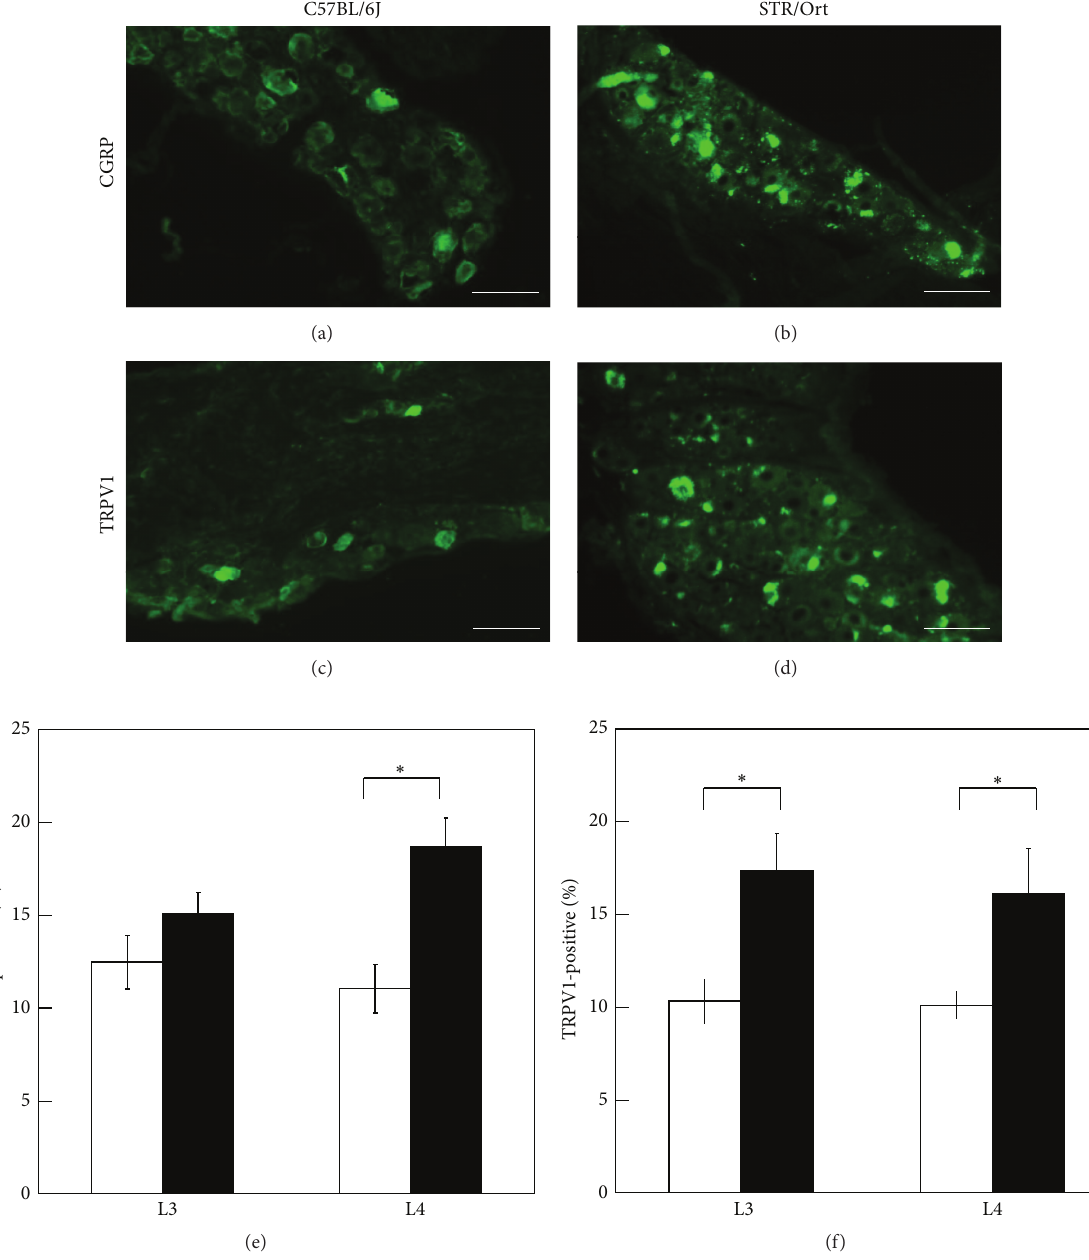
Figure 5: Expression of CGRP and TRPV1 in dorsal root ganglia. Expression of CGRP in L4 dorsal root ganglia of C57BL/6J (a) and STR/Ort mice (b). Expression of TRPV1 in L4 dorsal root ganglia of C57BL/6J (c) and STR/Ort mice (d). Scale bar = 100 𝜇 m. Percentage of CGRP- positive (e) and TRPV1-positive (f) cells in dorsal root ganglia of C57BL/6J and STR/Ort mice. Ten C57BL/6J and STR/Ort mice were used for this experiment. Data are presented as the mean ± SE ( 𝑛 = 10 ). ∗ 𝑝 < 0.05 versus